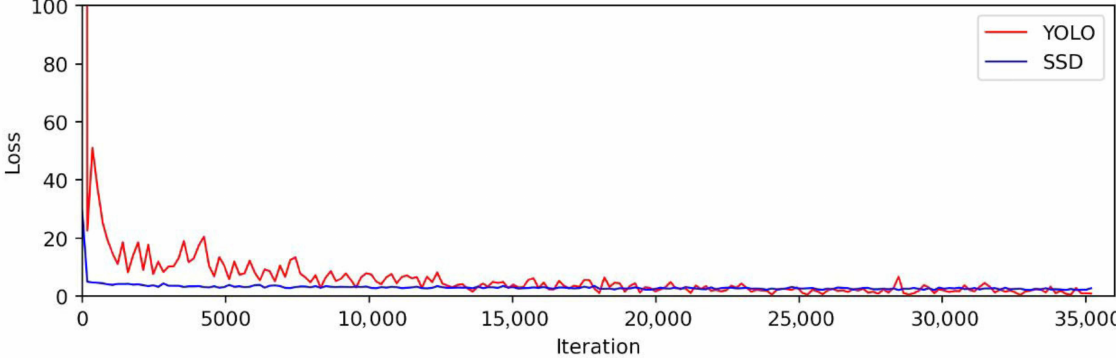
Figure 9. Performance comparison of object